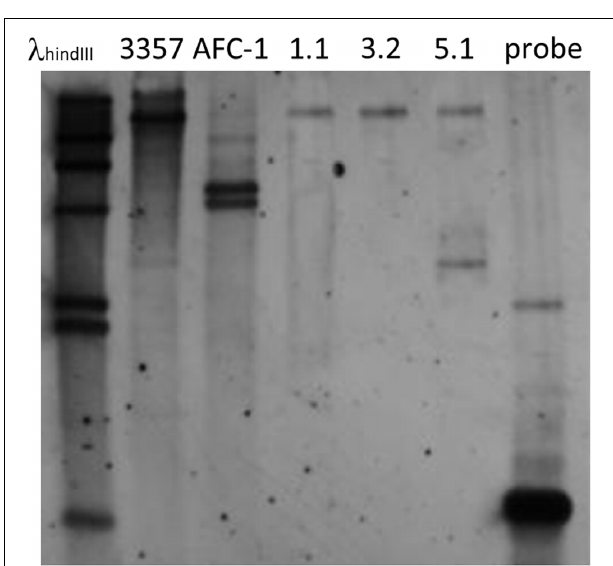
FIGURE 3 | Gel blot analysis of Af lox1 gene replacement mutants. Genomic DNA was isolated from the WT strain, the arginine auxotroph AFC-1 strain and gene replacement transformants (Af lox1 (cid:2) ). The blot was hybridized at 65 ◦ C with a 0.65-Kb argD DIG-labeled probe. Lane 1 DIG-labeled λ hindIII (Roche) used as molecular weight marker; lane 2 EcoR I-restricted genomic DNA of A. flavus WT strain; lane 3 EcoR I-restricted genomic DNA of A. flavus AFC-1; lane 4–6 EcoR I-restricted genomic DNA of Af lox1 (cid:2) strains (clone number 3 out of a set of 20 transformants screened); lane 7 argD 0.65Kb PCR fragment.